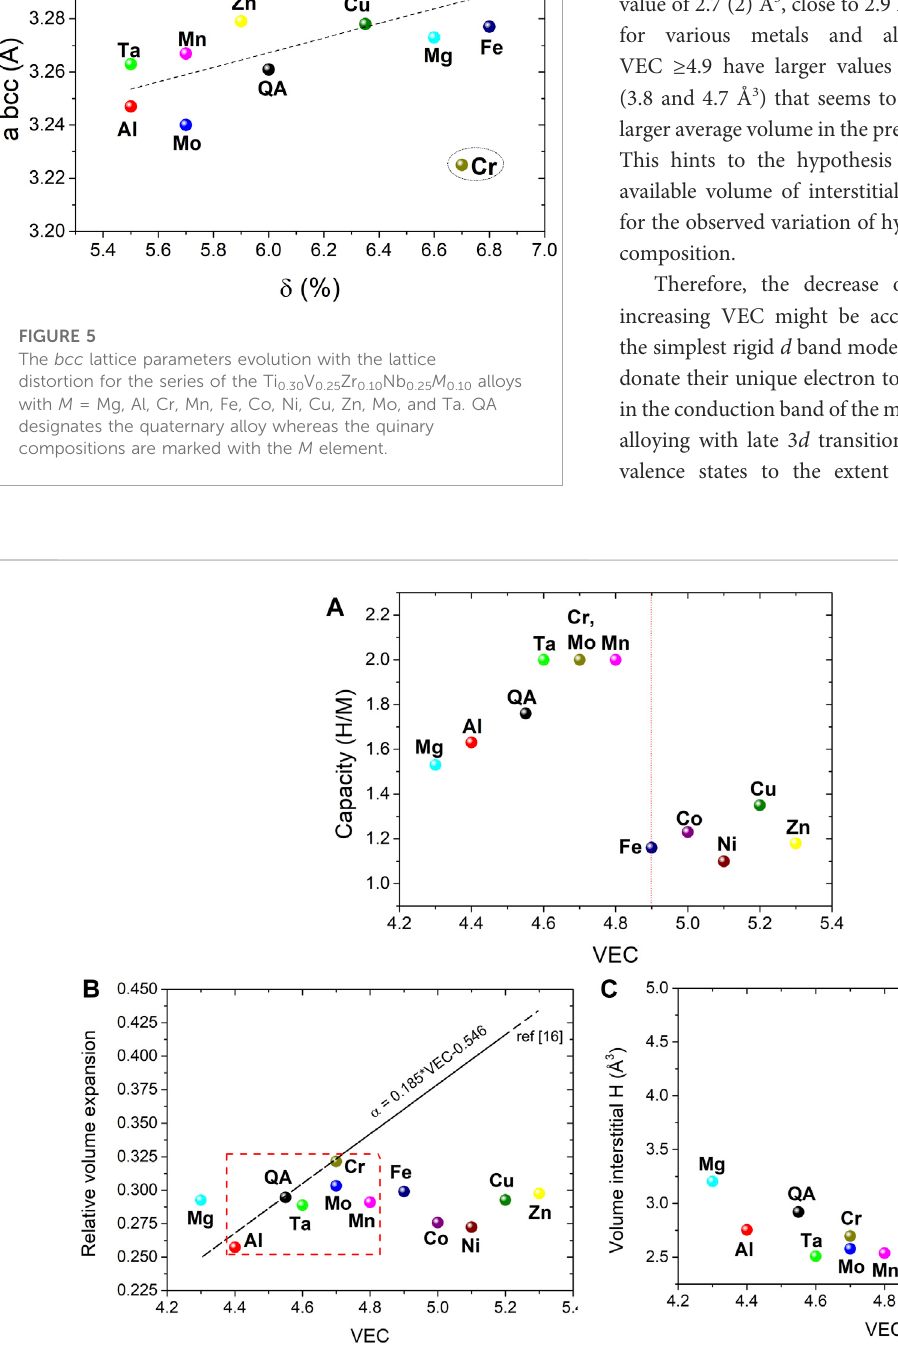
Figure 6C. Consistent with previous result, there are two groups of alloys depending on VEC. The alloys with VEC < 4.9 show a